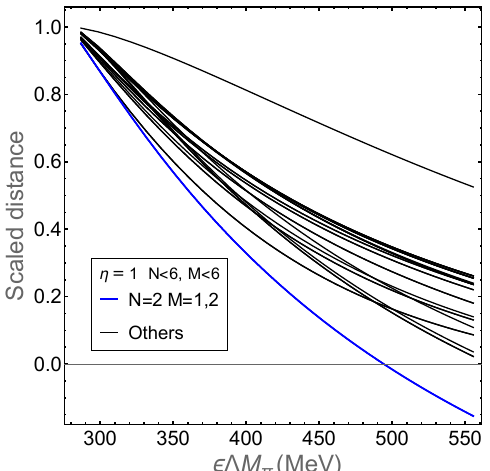
Figure 8 . Distances between the improved bound planes and a (cid:12)ducial point of b i (the central value of the empirically (cid:12)tted values in eq. (4.12)) in the ( b 1 ; b 2 ; b 3 ; b 4 ; b 5 ; b 6 ) space for (cid:17) = 1, t = 4 at di(cid:11)erent energy scales. The distances are normalized to 1 at (cid:15) (cid:3) = 2 (i.e., the original Y bounds without improved subtractions) to facilitate visualization in the plot, and a negative distance indicates that the positivity plane has excluded the (cid:12)ducial point. The f N = 2 ; M = 1 ; 2 g bounds are the (cid:12)rst bounds to become negative at (cid:15) (cid:3) M (cid:25) ’ 490MeV, beyond which the improved bounds become